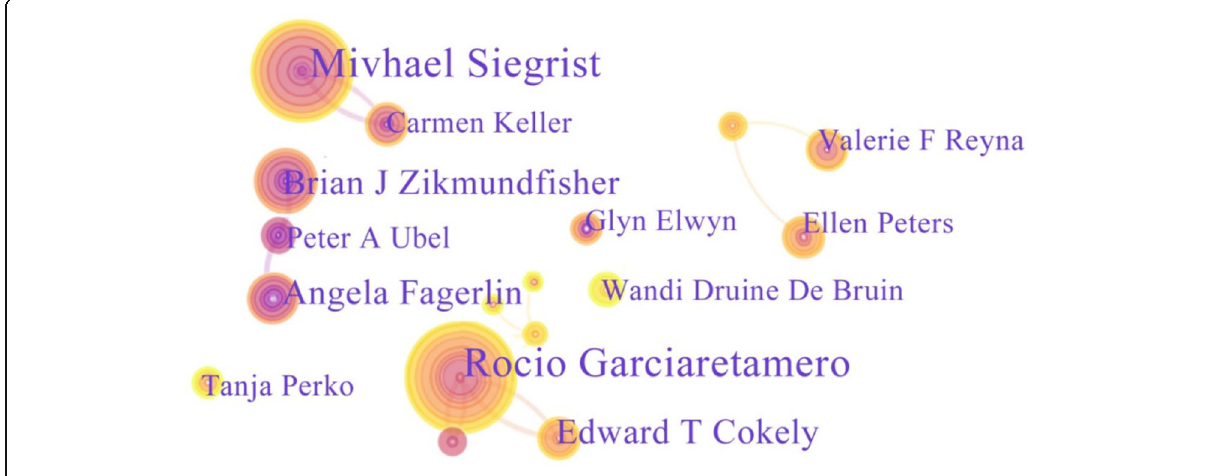
Fig. 2 Co-author network of international